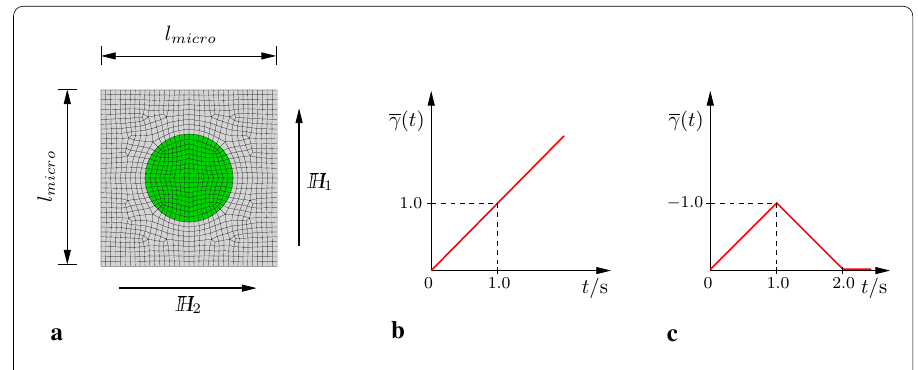
Fig. 5 RVE under macroscopic loading conditions. An RVE with circular inclusion of volume fraction f 0 = π/ 16 is attached to a macroscopic material point X and driven by the macroscopic fields H = 0 m / s and Div H = γ s −